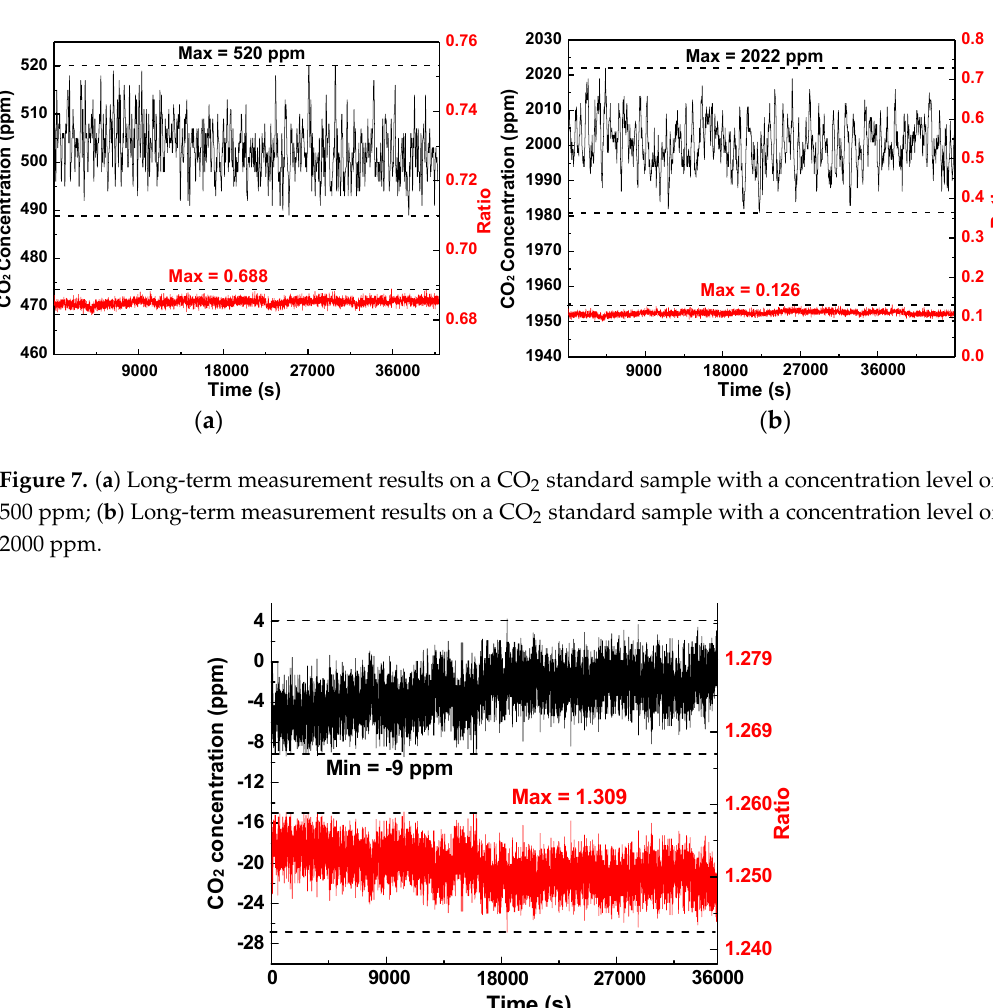
Figure 8. Long-term measurement results on a 0-ppm CO 2 sample (pure N 2 ) for 10 h with a 1-s sampling period.